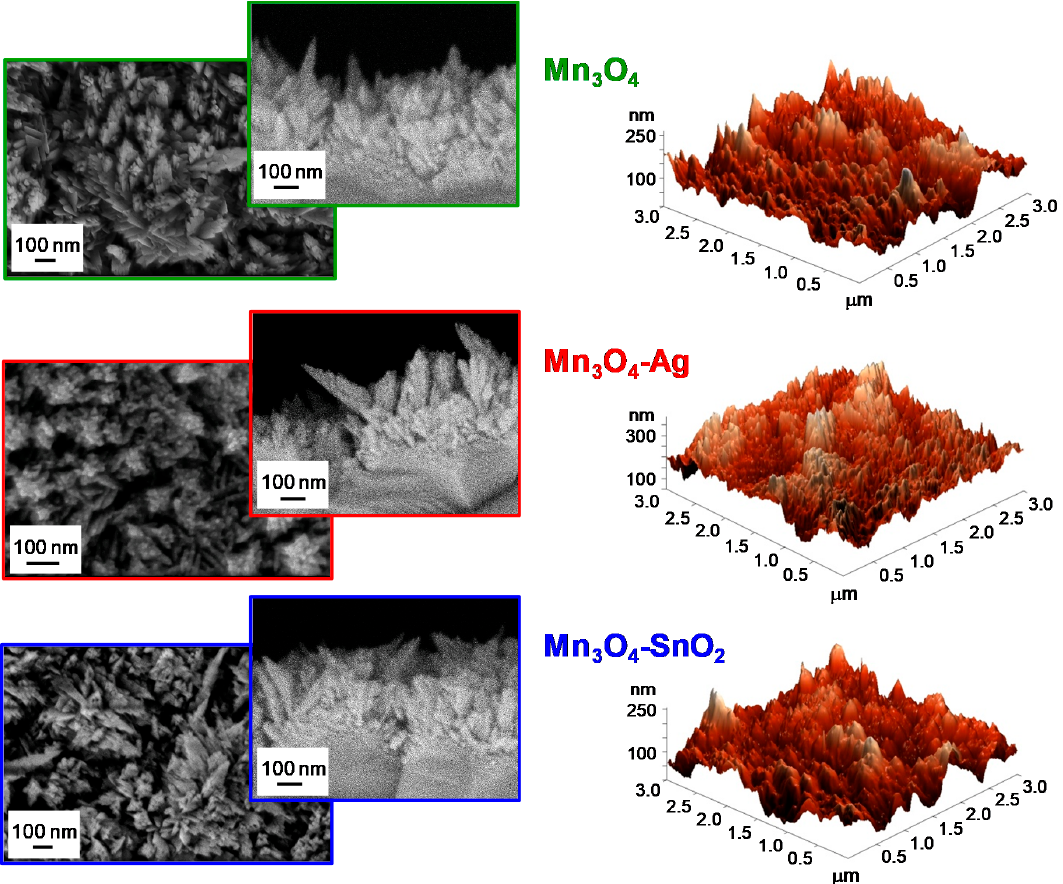
Figure 5. Representative plane-view and cross-sectional field emission-scanning electron microscopy (FE-SEM) micrographs (left panels) and atomic force microscopy (AFM) images (right panels) for Mn 3 O 4 , Mn 3 O 4 -Ag and Mn 3 O 4 -SnO 2 samples.